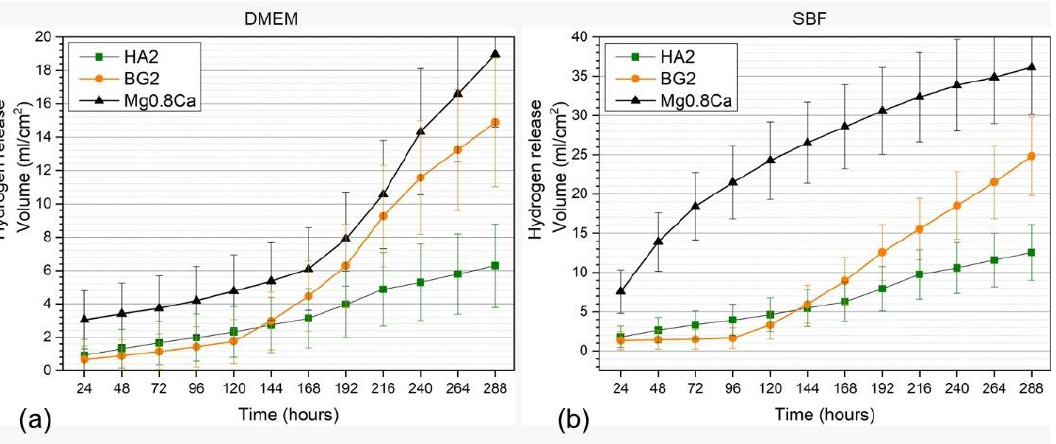
Figure 6. Hydrogen release evolution in ( a ) DMEM and ( b ) SBF testing media of the bare and HA2- and BG2-coated Mg-0.8Ca specimens.